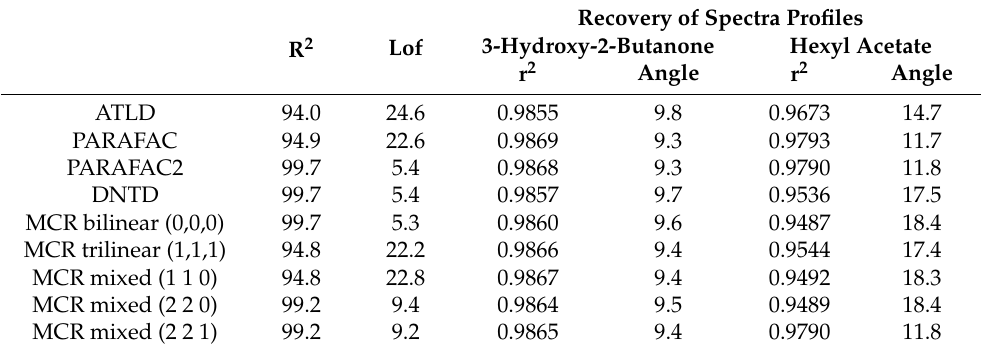
Table 2. Comparison of results obtained by ATLD, PARAFAC, PARAFAC2, DNTD and different variants of MCR-ALS in the analysis of the wine GC-MS dataset. In bold red are worse recovered profiles with r 2 values below 0.9. See Equations (7)–(10) for the meaning of R 2 , lof, r 2 and angle. See end of Section 2.2 for the meaning of the different MCR-ALS